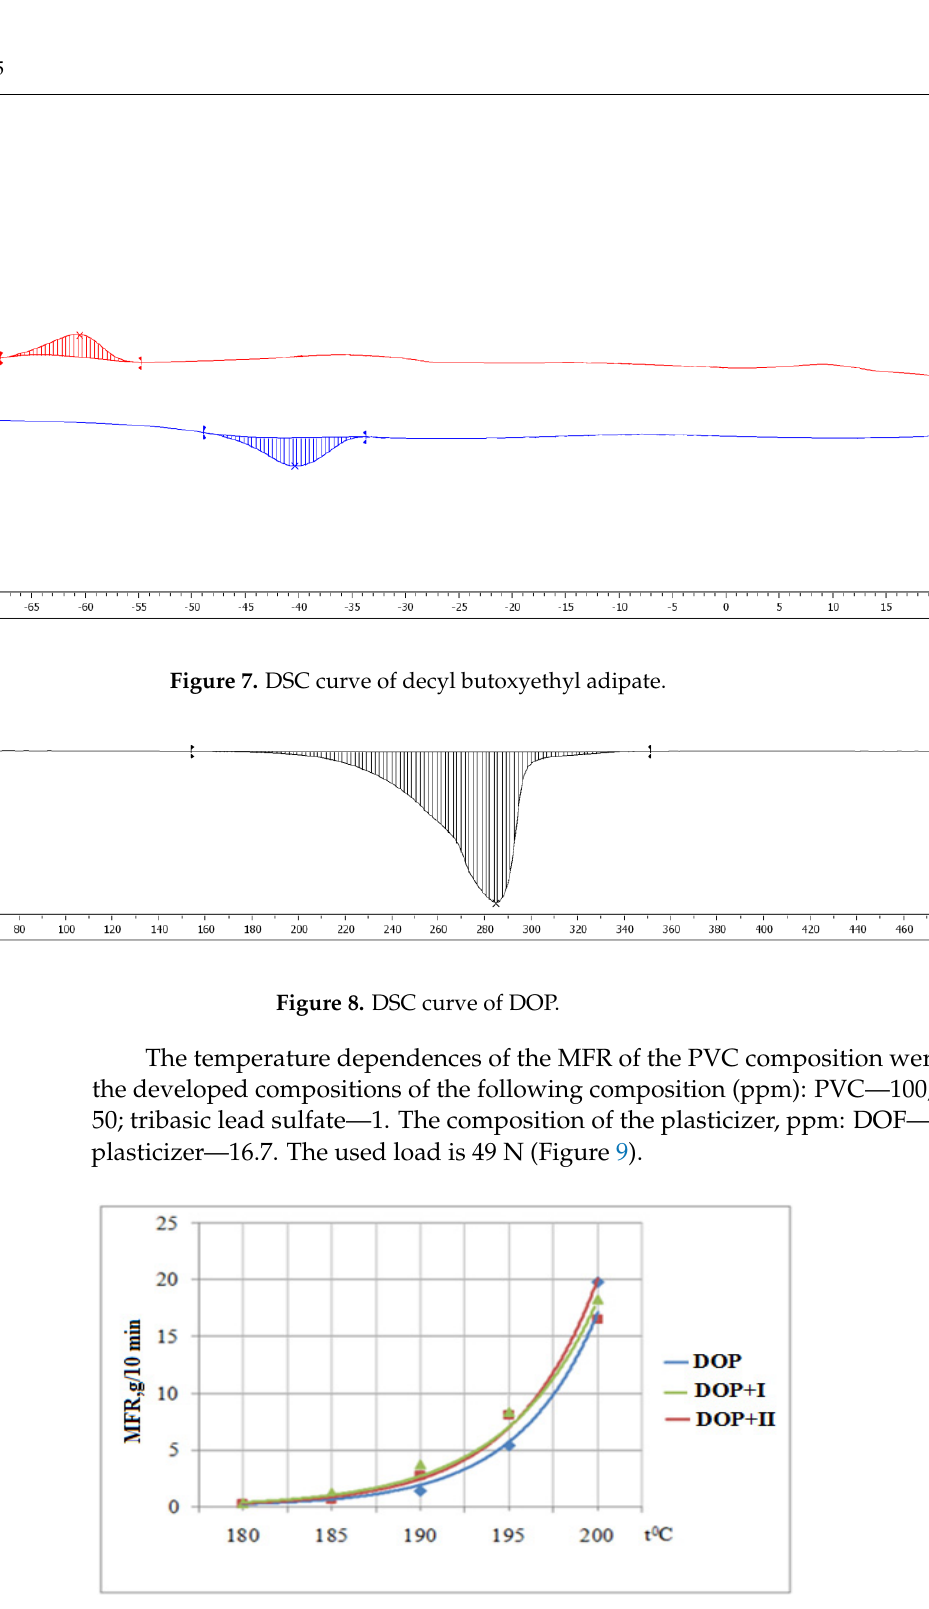
Figure 9. Dependence of the MFR of PVC composition on temperature. I–II—Symbols of plasticizers (Table